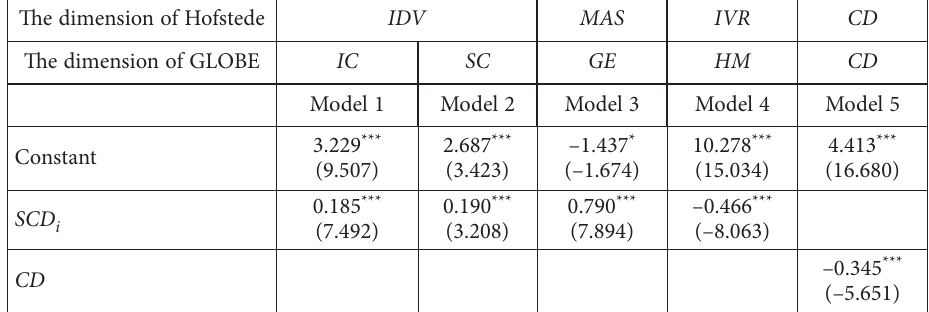
Table 6. Regression results of the GLOBE culture on IPO underpricing (source: authors’ calculation) The dimension of Hofstede The dimension of